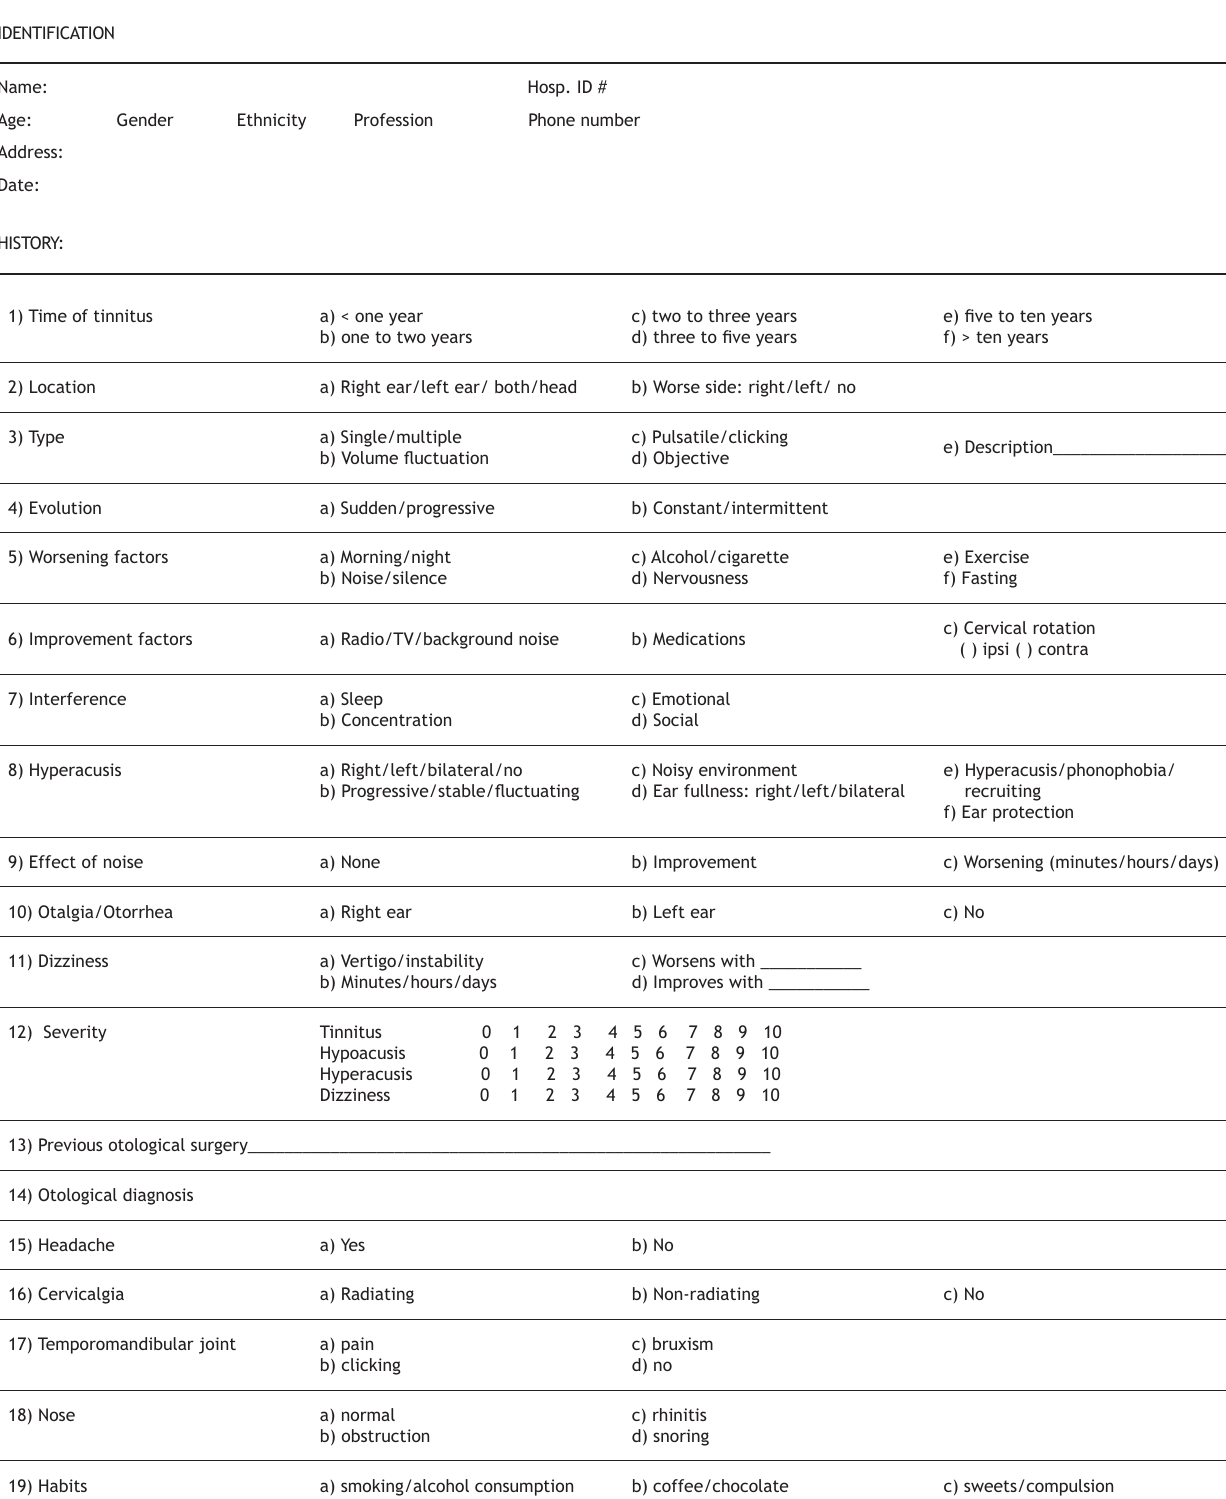
Figure 1 Questionnaire used to assess patients with